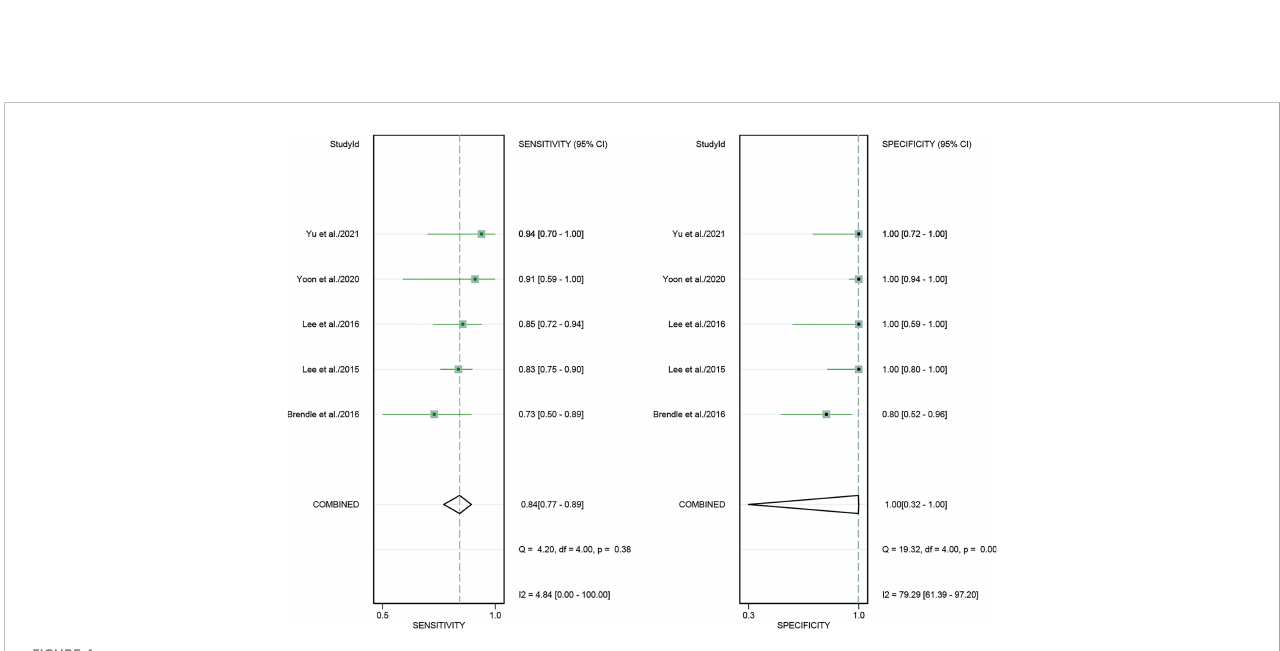
FIGURE 4 Forest plots of the combined [18F]FDG PET/MRI sensitivity and speci fi city for colorectal liver metastasis. Squares denoted the sensitivity and speci fi city in each study, while horizontal bars indicated the 95% con fi dence